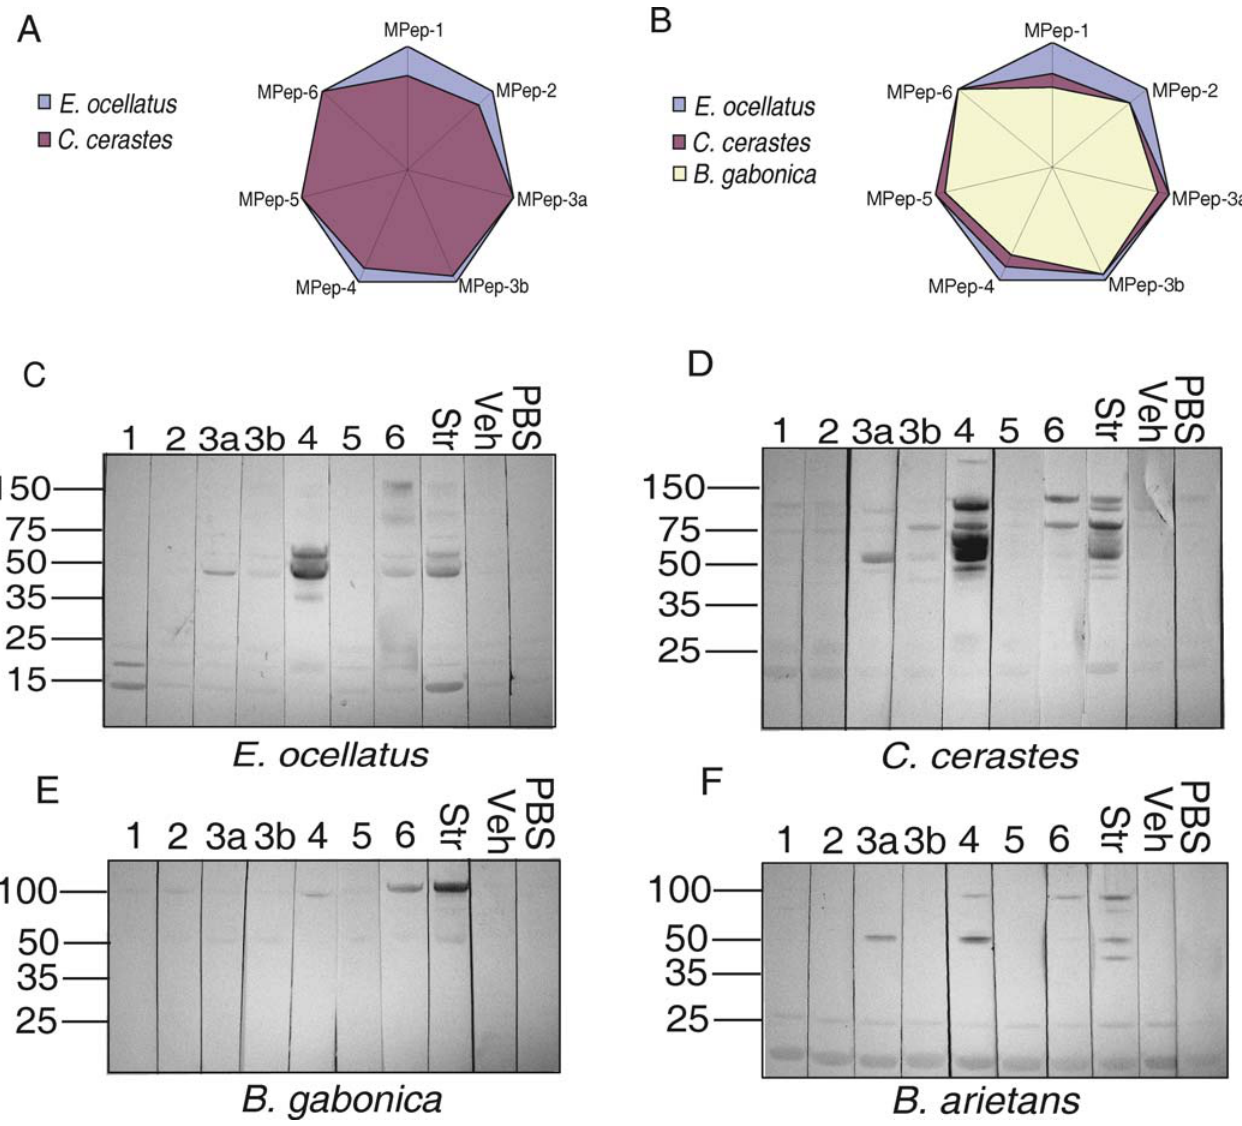
Figure 5. Prediction and Experimental Verification of the Immunological Conservation of EoMPep 1–6 in Phylogenetically Distinct African Viper Species (A and B) The immunological conservation of EoMPep 1–6 is predicted using radar charts comparing the percentage highest bit score results generated by BLAST searches of EoMPep 1–6 against the E. ocellatus venom gland EST database (VgDbEST) (taken as 100%) with BLAST searches against VgDbEST databases from (A) C. cerastes (SCW, unpublished data, 2006) and (B) the latter and B. gabonica [35]. (C–F) Experimental assessment of immunological cross-reactivity using pooled sera raised against EoMPep 1–6 as individual MAPs (indicated as numerals 1–6 above each blot) and EoSVMP string (Str) following nonreduced immunoblotting of whole venom of four viper species (indicated below each blot). Molecular mass markers are shown to the left. Veh, pVaxSec DNA vehicle control. DOI: